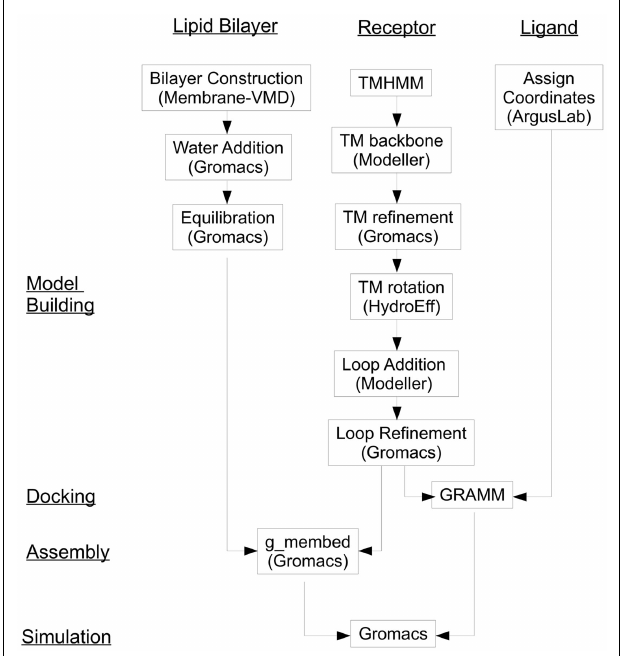
FIGURE 1 | OR and GPCR end-to-end modeling and simulation flow diagram.